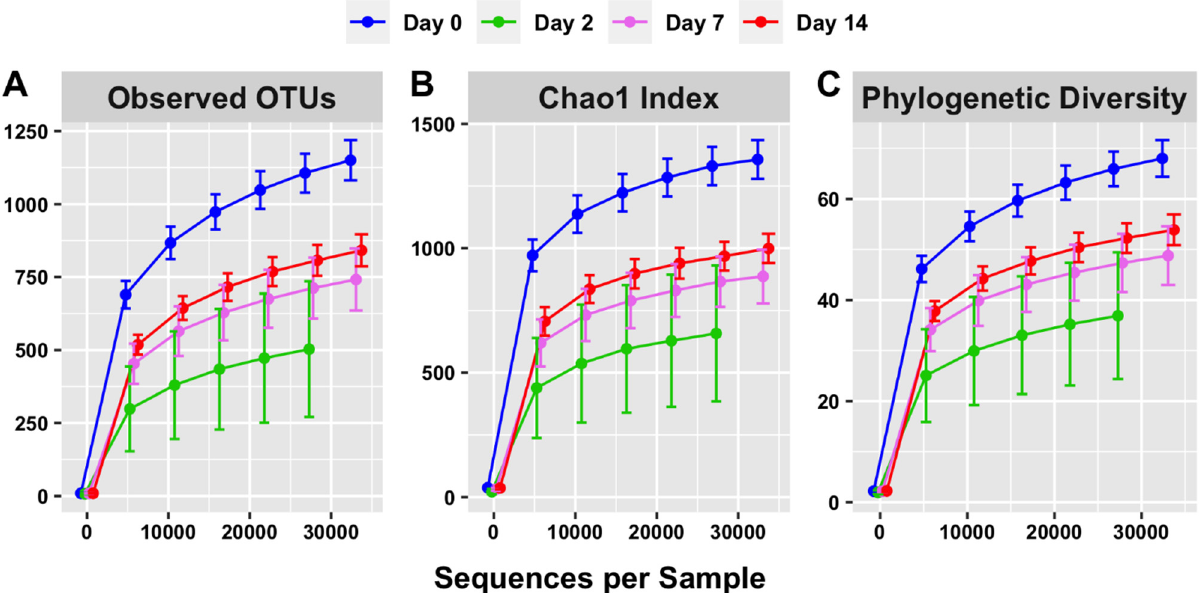
Figure 5. Alpha diversity (within-sample) rarefaction curves measuring species richness of the intestinal microbiota on days 0, 2, 7 and 14. Observed OTUs ( A ), Chao 1 ( B ) and phylogenetic diversity ( C ) relate to the numbers of different microorganisms present in a sample (diversity) compared with how many sequences per sample were used. Error bars are staggered and representative of range.